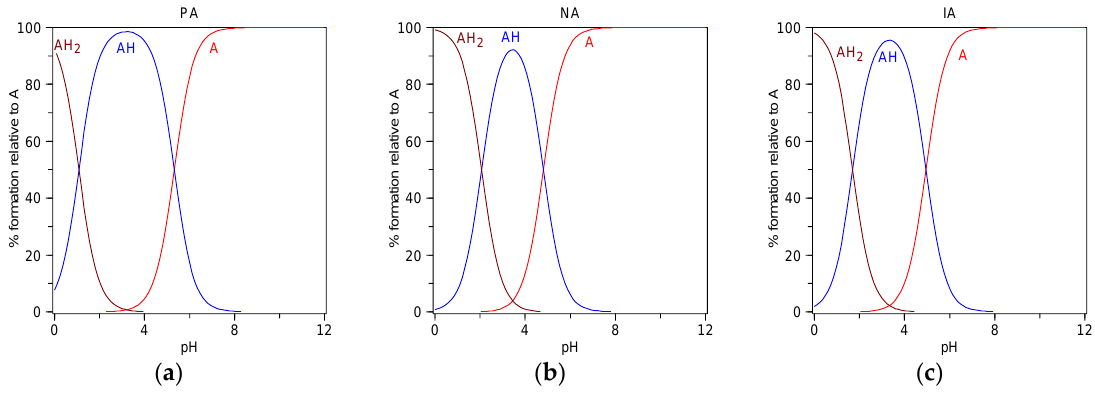
Figure 8. Species distribution diagrams for PA ( a ), NA ( b ), and IA ( c ), in aqueous solution, calculated with the protonation constants presented in Table 7.